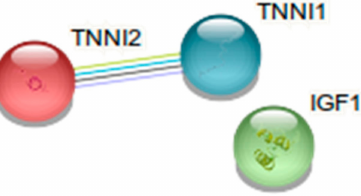
Figure 4. Protein-protein interaction map of possible biomarkers for other hepatic GSDs extracted from Table 2 using